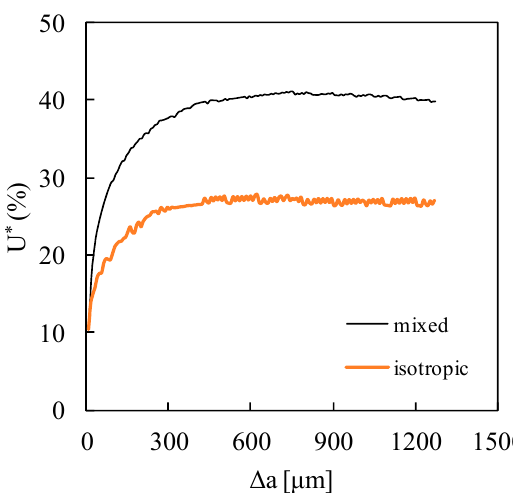
Figure 6. Crack closure level, U * , vs. crack increment (reference cases).